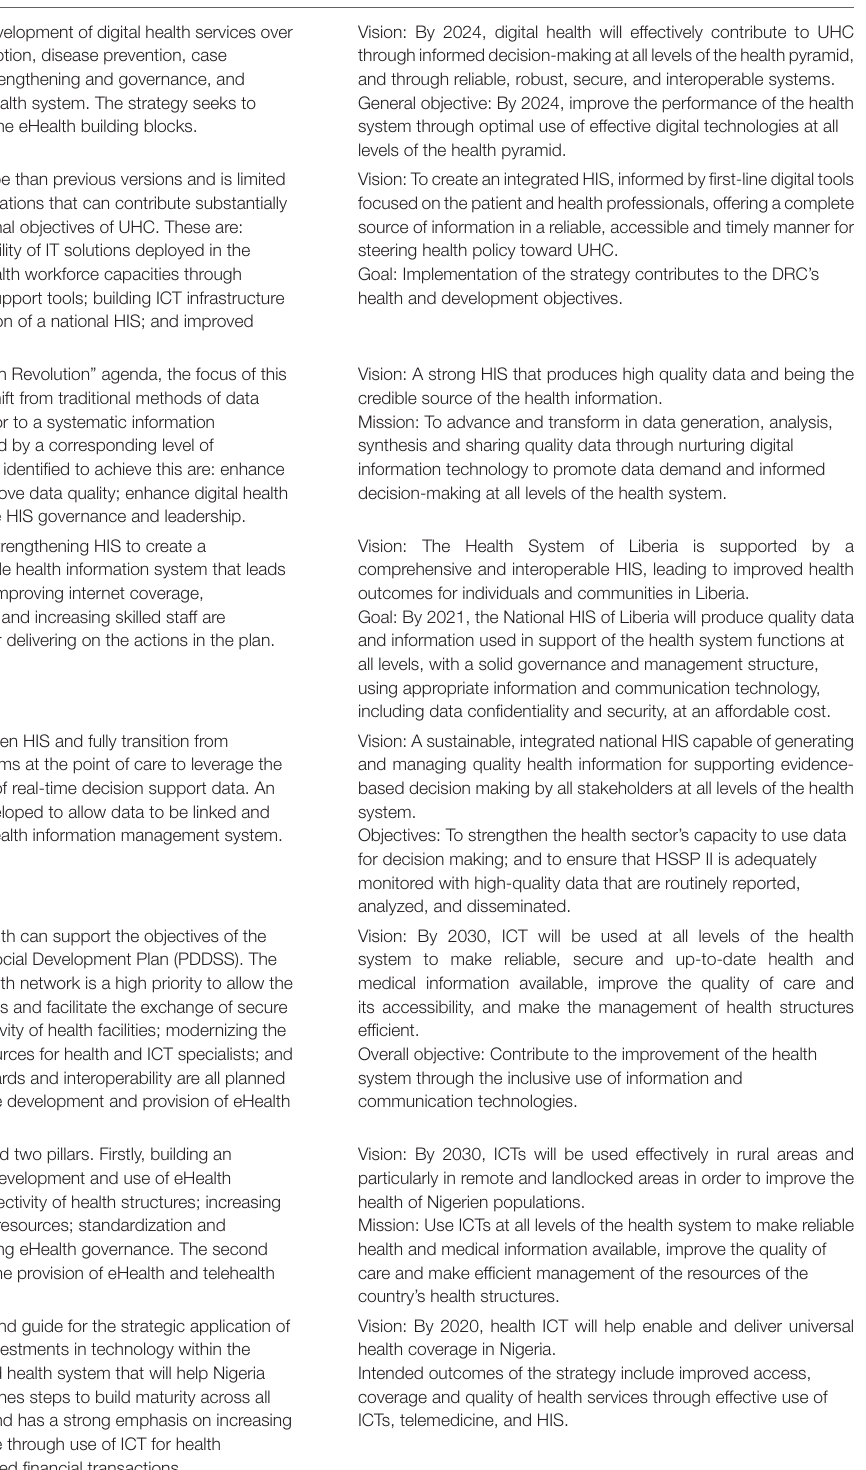
TABLE 3 | Strategy scope and aspirations. Strategy focus Overarching goal and